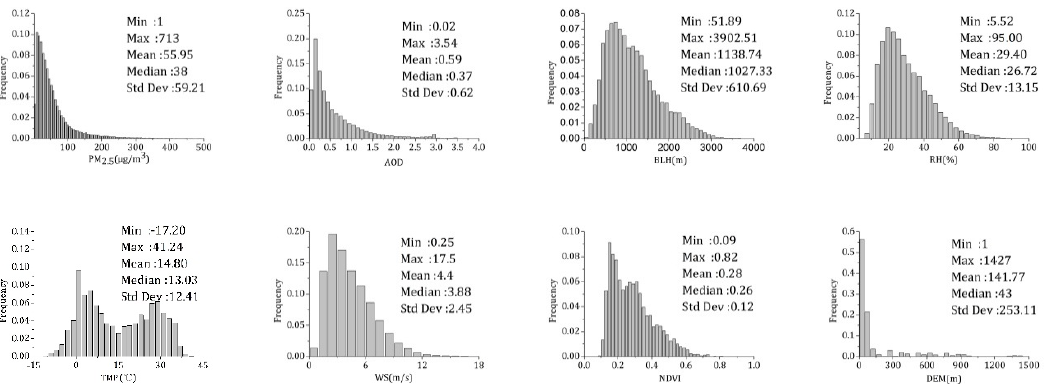
Figure 4. Scatterplots and statistical parameters of dark target (DT) and deep blue (DB) aerosol optical depth (AOD) ( a ), Method I ( b ), and Method II ( c ). The dashed lines represent the expected error (EE), the black solid line represents the 1:1 line, and the red line represents the fitted linear regression line.